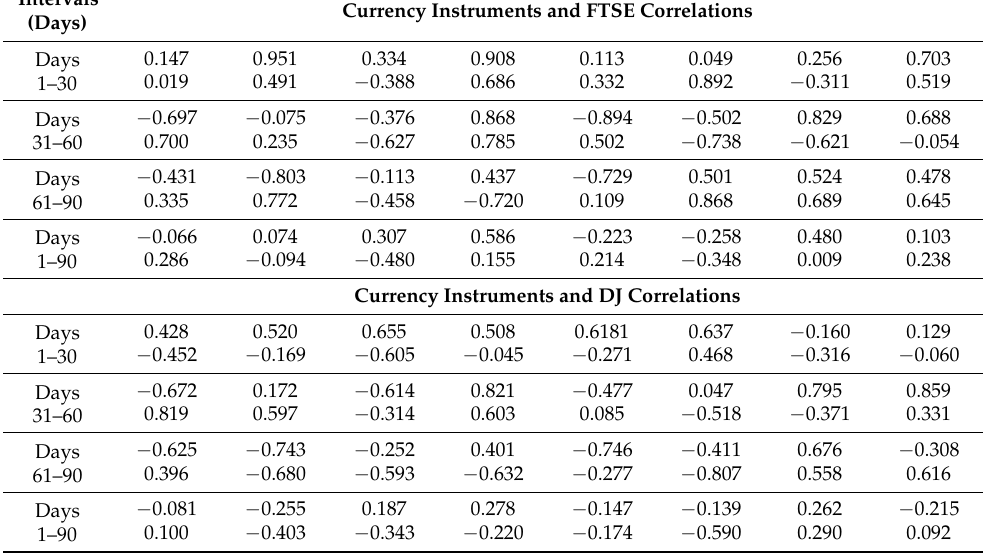
Table 2. Estimates of pairwise correlations between selected stock indexes and currency instruments. Intervals